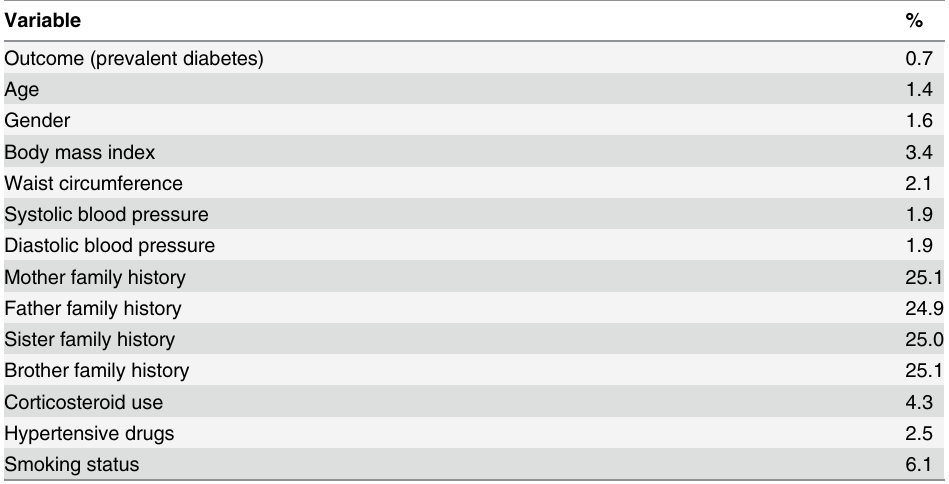
Table 2. Missingness